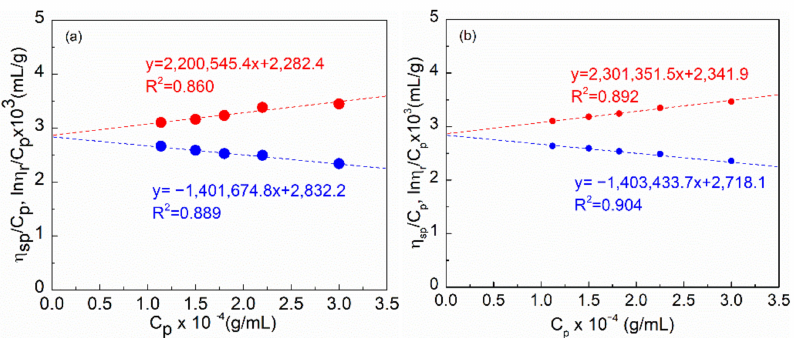
Figure 3. η sp /C p and ln η r /C p plotted as a function of polymer concentration for ( a ) HAP and ( b ) HPAM at 30 ◦